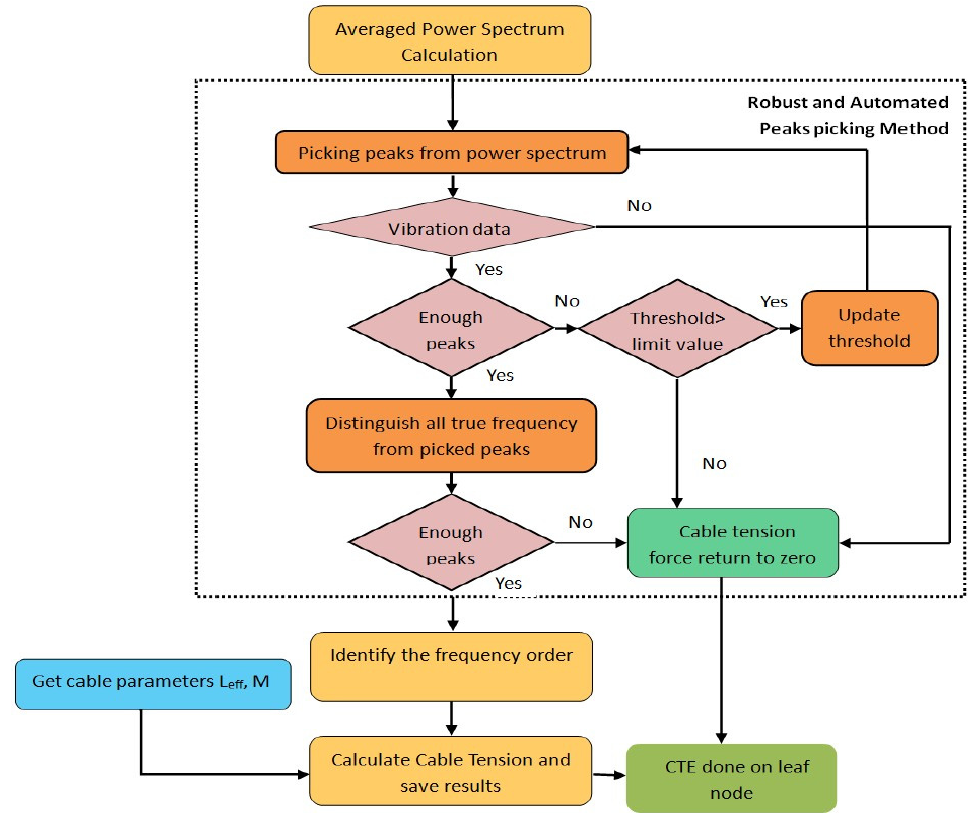
Figure 3. Flowchart of automated and robust cable tension estimation method.